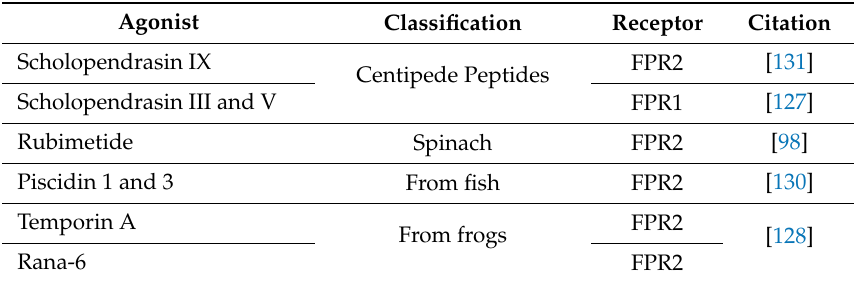
Table 7. Non-human, non-microbe-derived FPR (Fpr)